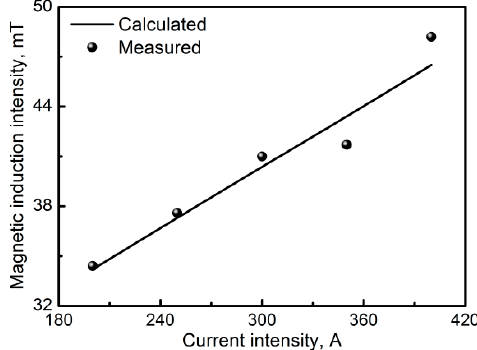
Figure 3. Magnetic induction intensity of S-EMS with di ff erent current intensities.